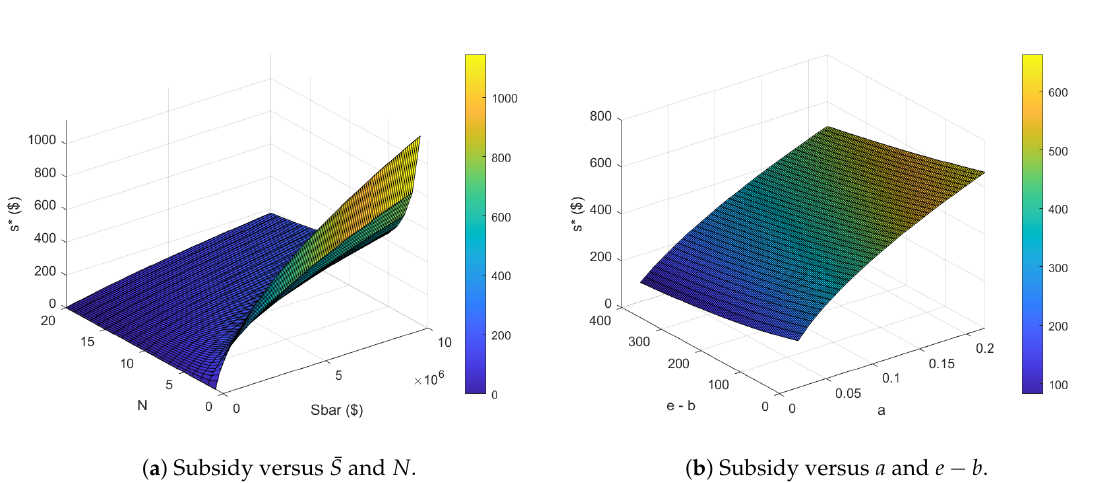
Figure 2. Subsidy per unit capacity for social-level optimization